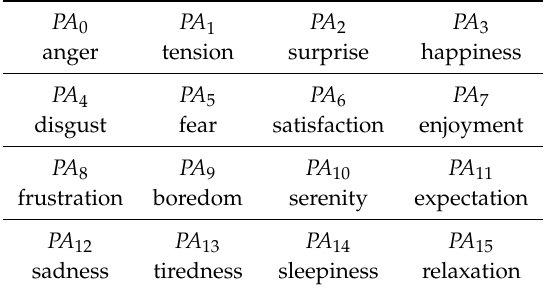
Table 2. Description of 16 emotions in Figure 4 and their notations.